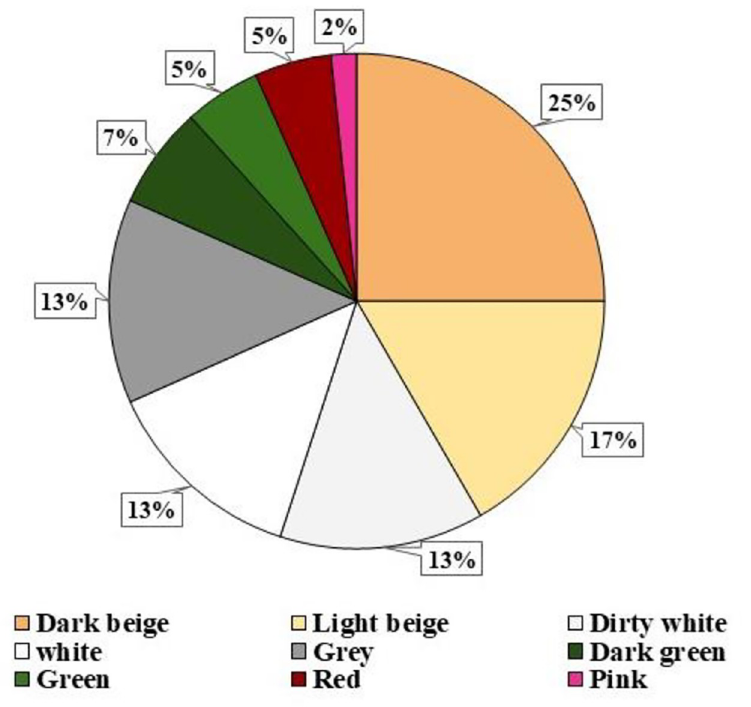
Fig 1. Morphological characters of Streptomyces sp. isolates according to their pigment